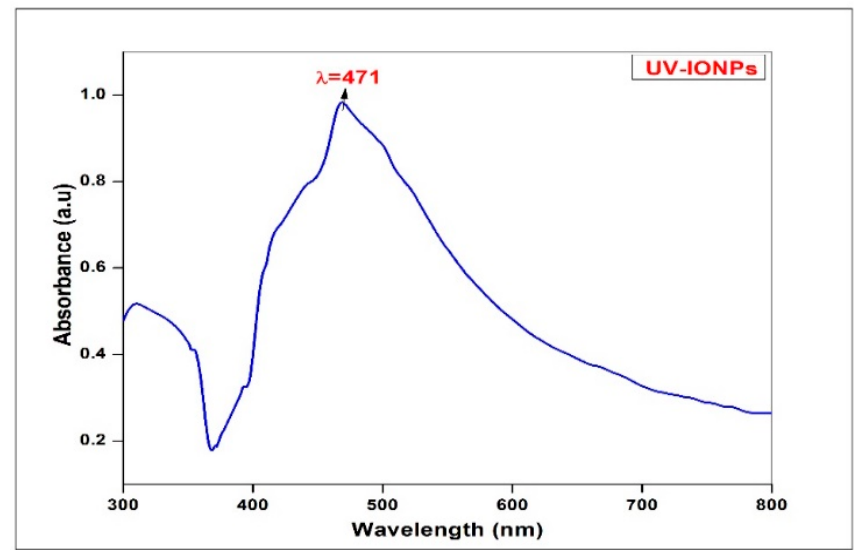
Figure 2. UV-visible spectra of Oscillatoria limnetica- mediated IONPs.